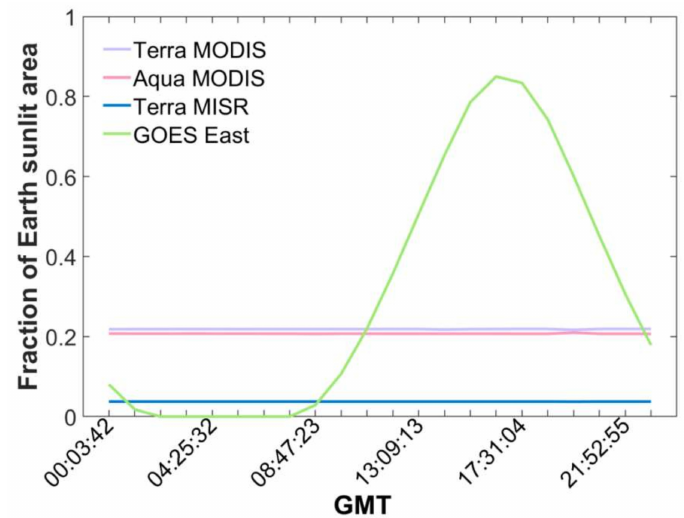
Figure 3. Hourly variation in sampling areas of Terra/Aqua MODIS, Terra MISR sensors, and GOES-East satellite. The MODIS and MISR swaths cover 20% and 5% of the sunlit Earth disk, respectively. The Earth sunlit area as seen from the GOES-East satellite varies during a